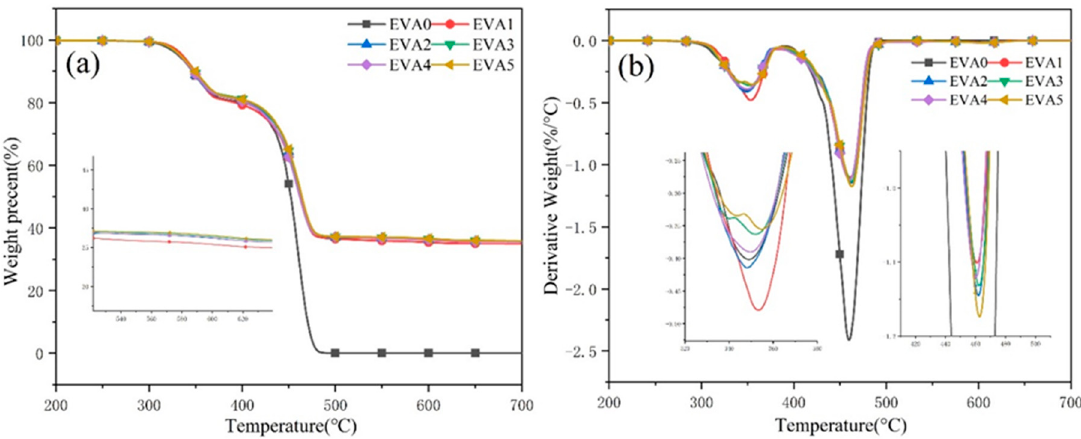
Figure 4. The particle size distribution diagram ( a ) and mean diameter ( b ) of MH powders. Diff, difference distribution, that is, the percentage of particles in a series of particle diameter intervals.